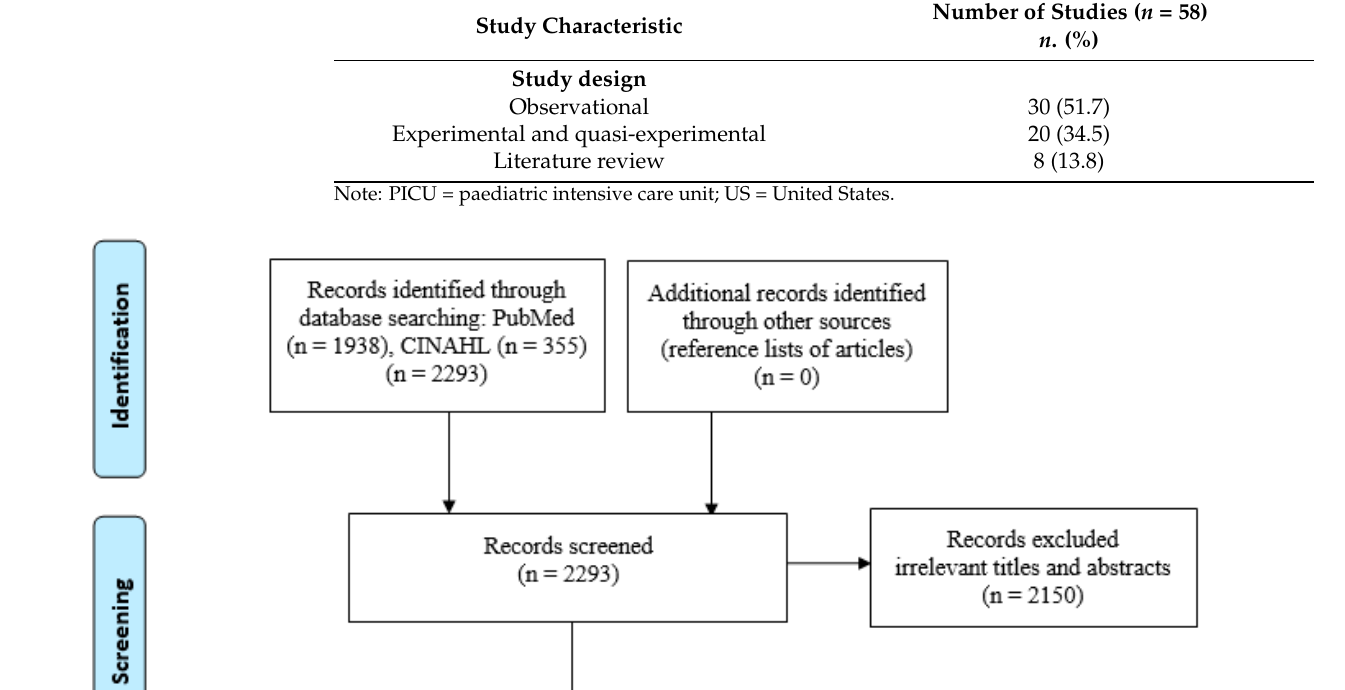
Table 3. Summary of the main study characteristics ( n = 58).